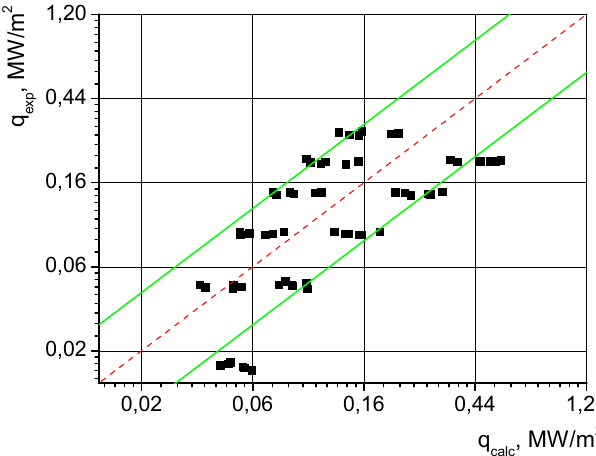
Figure 12. Comparison of the calculated and experimental test results for the laser textured surfaces and both boiling agents.